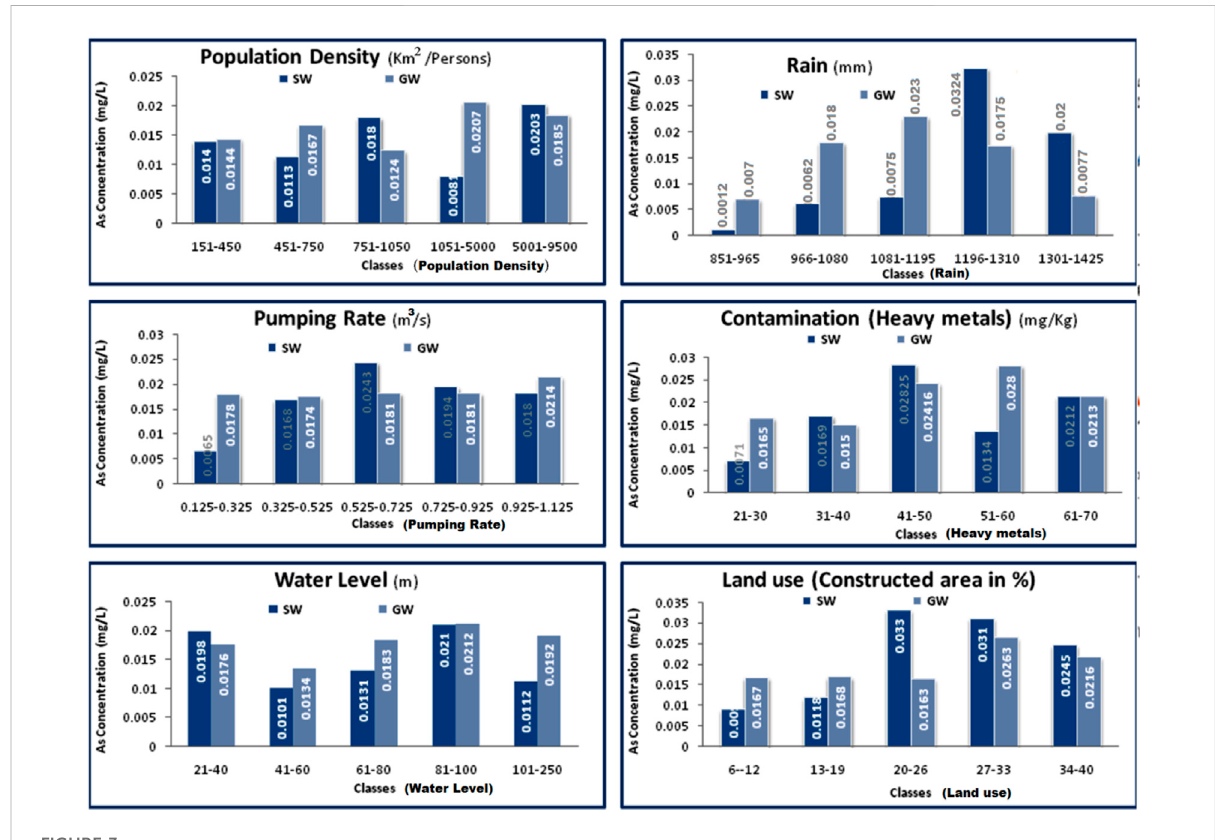
FIGURE 3 Factor classi fi cations and average arsenic concentration of each class in